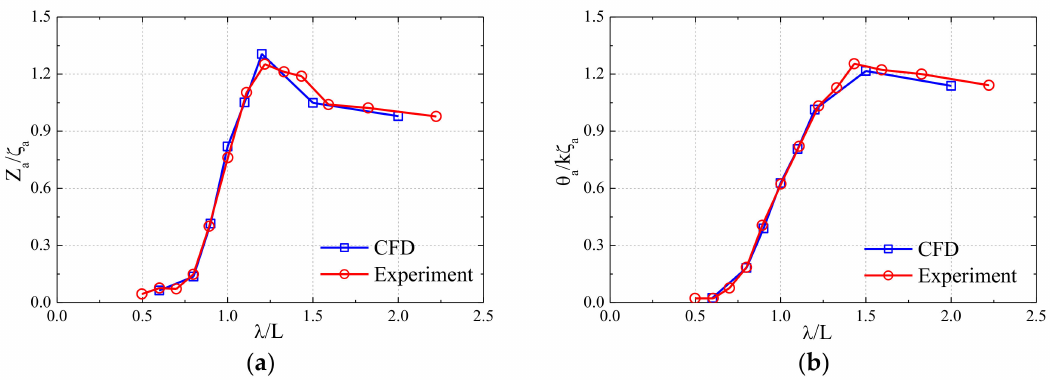
Figure 15. Comparison of experimental and numerical ship motions in head regular waves: ( a ) heave; ( b )